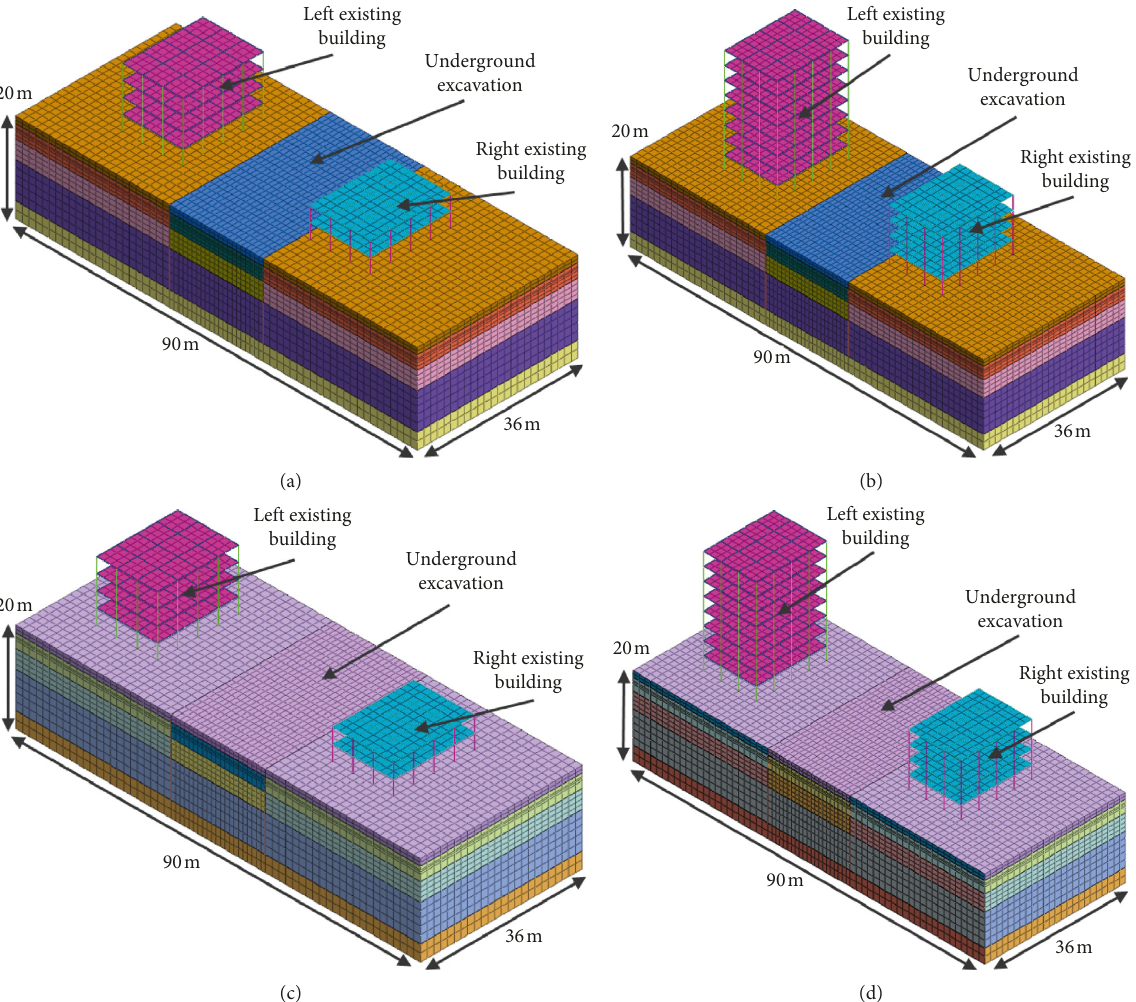
Figure 21: Finite element models of tests. (a) Test I. (b) Test III. (c) Test V. (d) Test